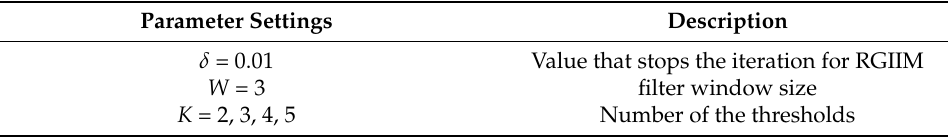
Table 1. Parameter settings of the proposed